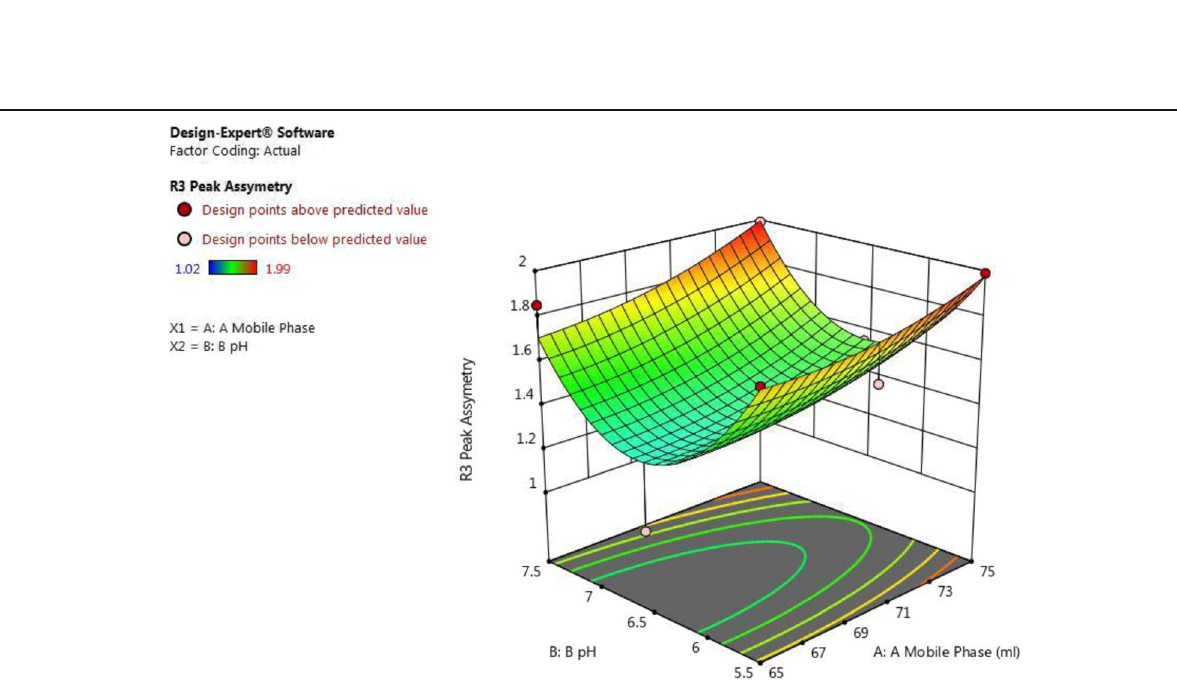
Fig. 3 3D surface plot for effect of combination of factors on R3 peak asymmetry of ceftriaxone sodium by using central composite